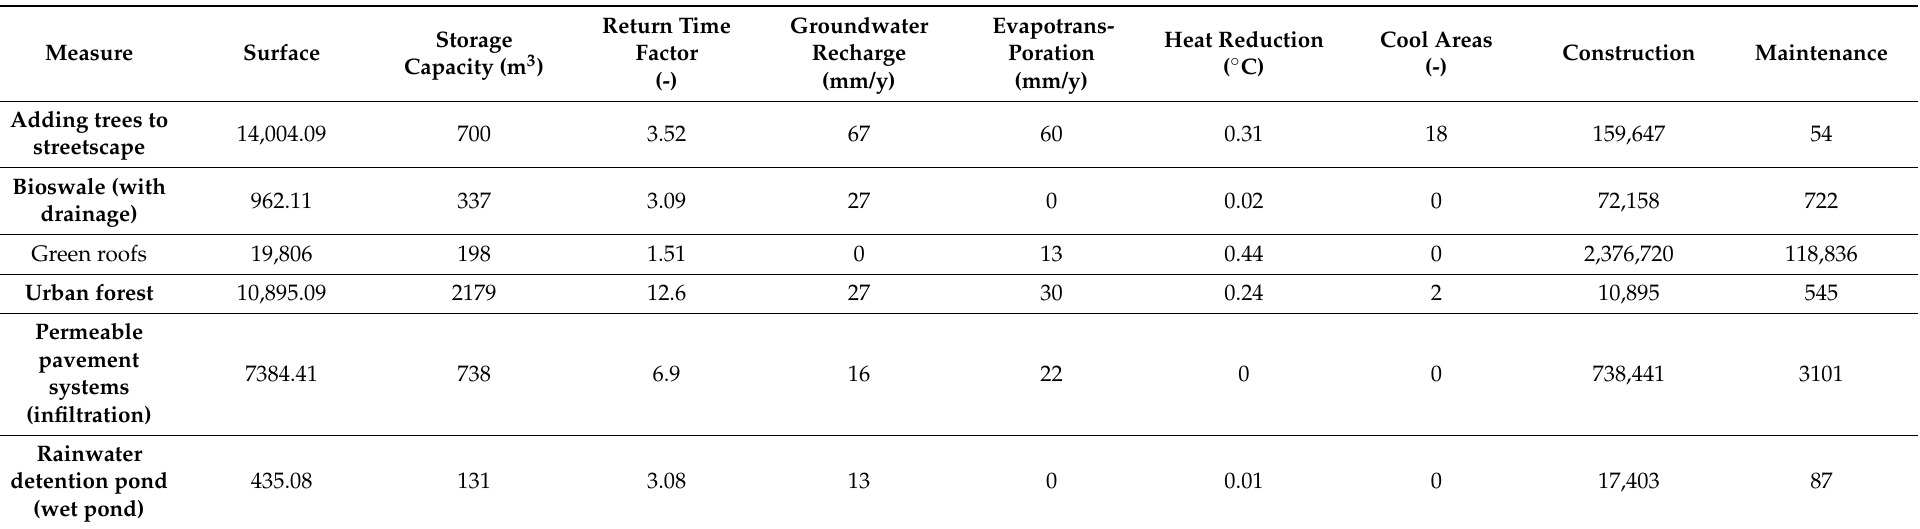
Table 5. Impact on climate and costs calculated with AST (source: